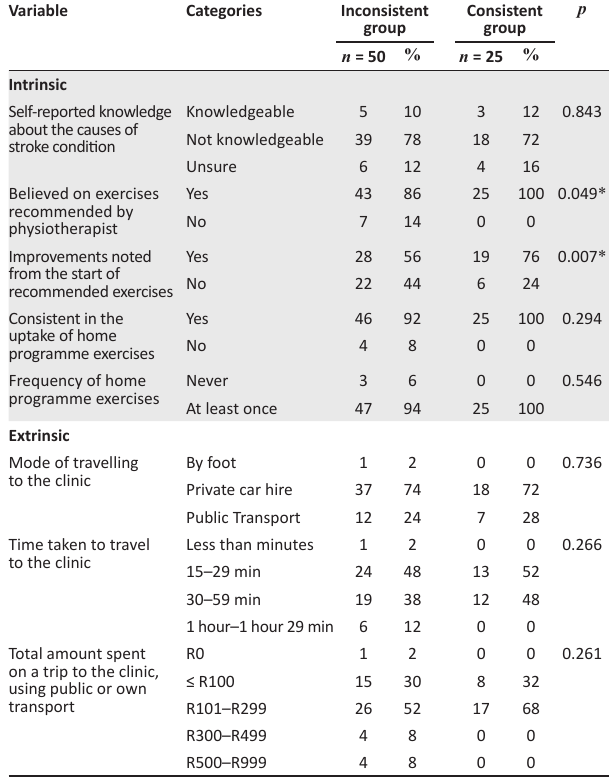
TABLE 3: Associations between a range of intrinsic and extrinsic variables and inconsistent uptake of physiotherapy interventions (overall n = 75).